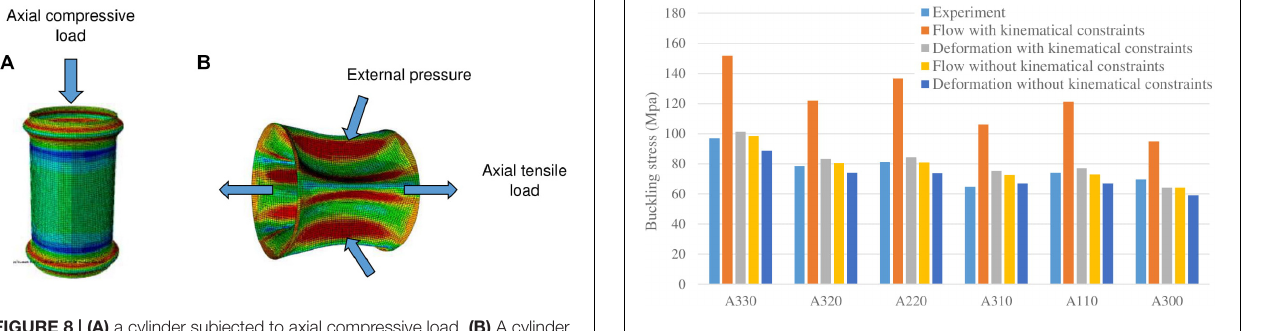
FIGURE 9 | Comparison between the buckling stresses obtained numerically with and without kinematic constraints (Shamass et al., 2014, 2015a,b,